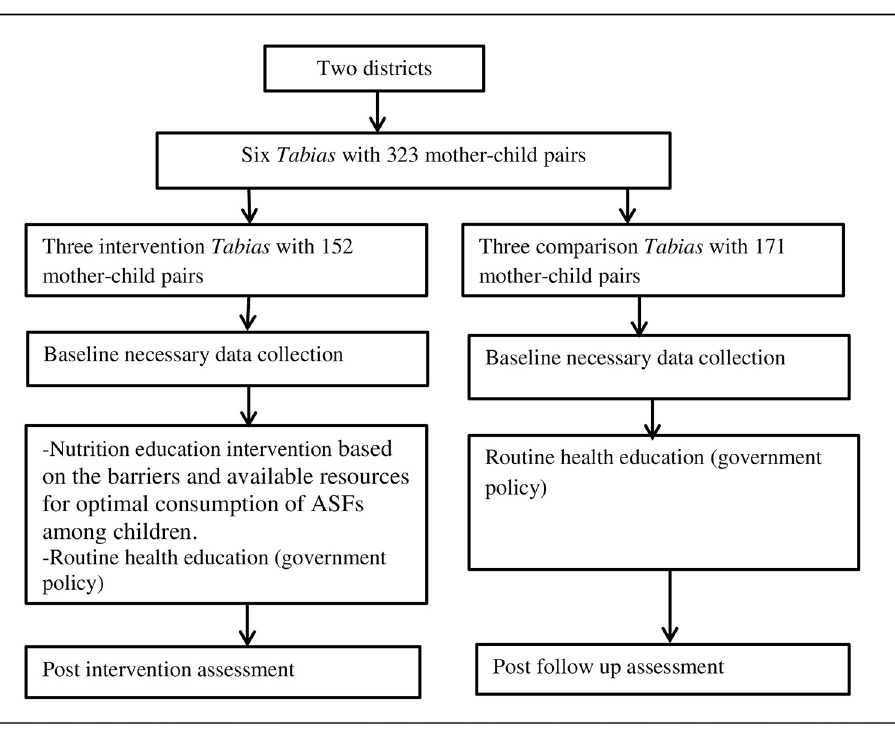
Fig 1. Schematic representation of the intervention protocol.